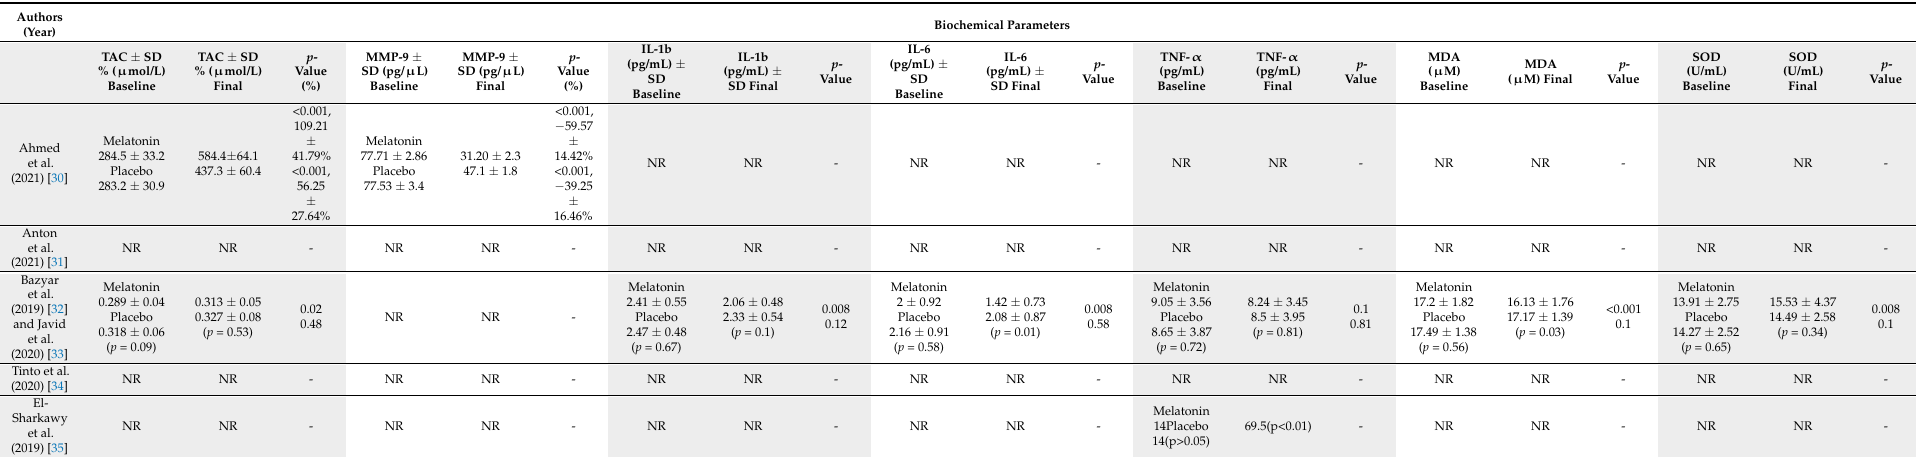
Table 5. Biochemical parameters found in the included studies (Part I).